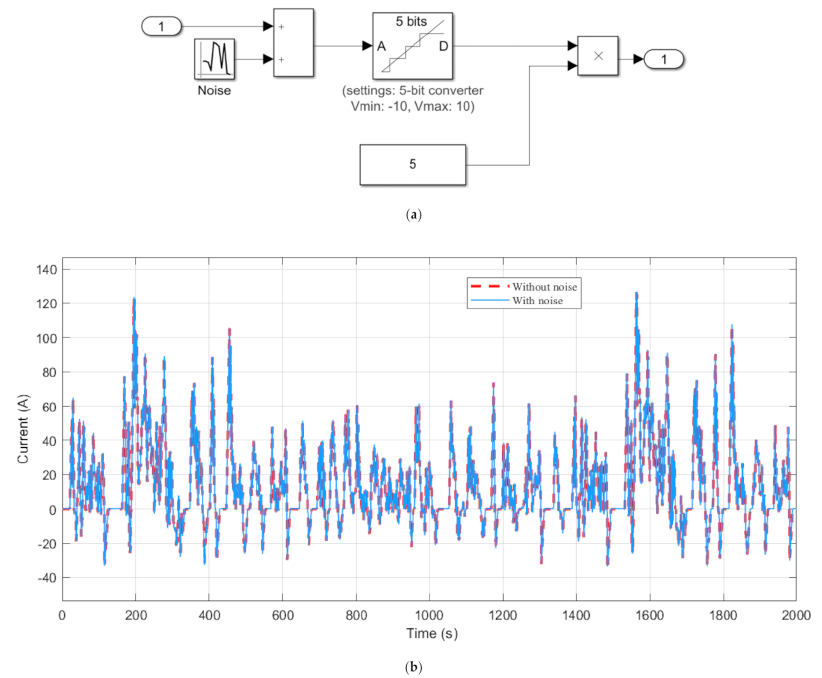
Figure 2. Current sensor model; ( a ) the Matlab/Simulink block, and ( b ) current sensors with and without noises.